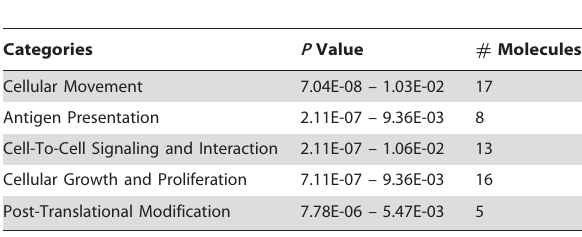
Table 4. Ontology analysis of 27 genes located in cell membrane.